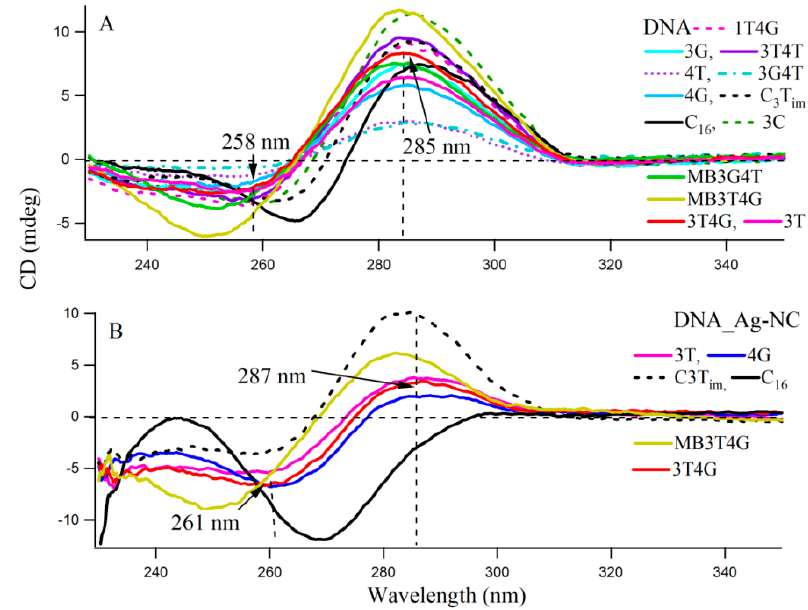
Figure 3. Circular Dichroism spectra of ( A ) 10 μ M DNA and ( B ) 15 μ M Ag-NC conjugated DNA at pH 6.5 citrate buffer solution. The vertical dashed lines show the wavelengths which characterize the formation of the unusual DNA structural motif, namely C 4 i-motif.